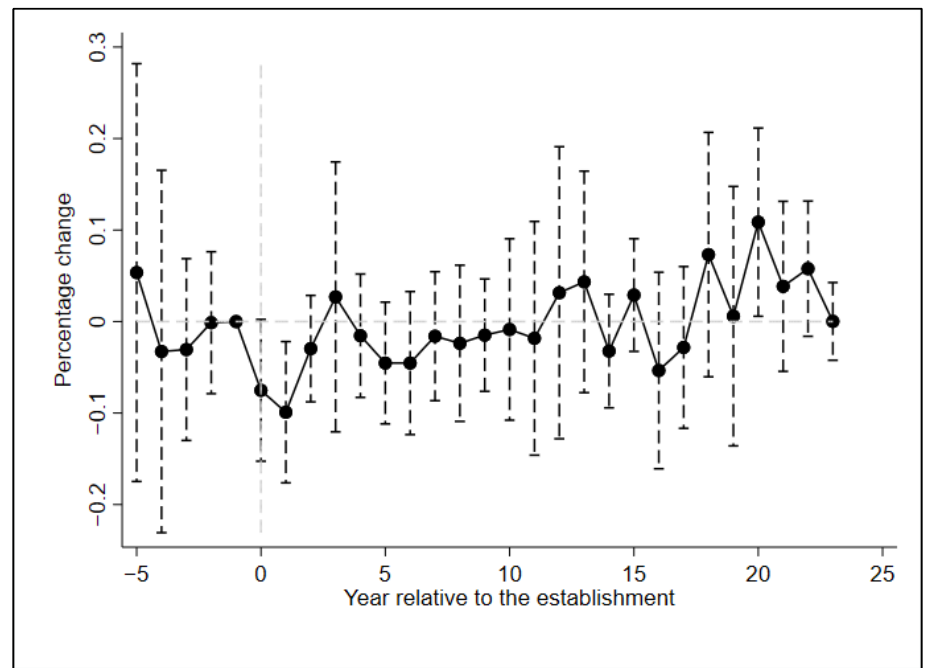
on the dz indicator with county and year FE. As seen, the negative effect of development zones is driven by the “Never vs Timing” effect, which is consistent with Table 6.